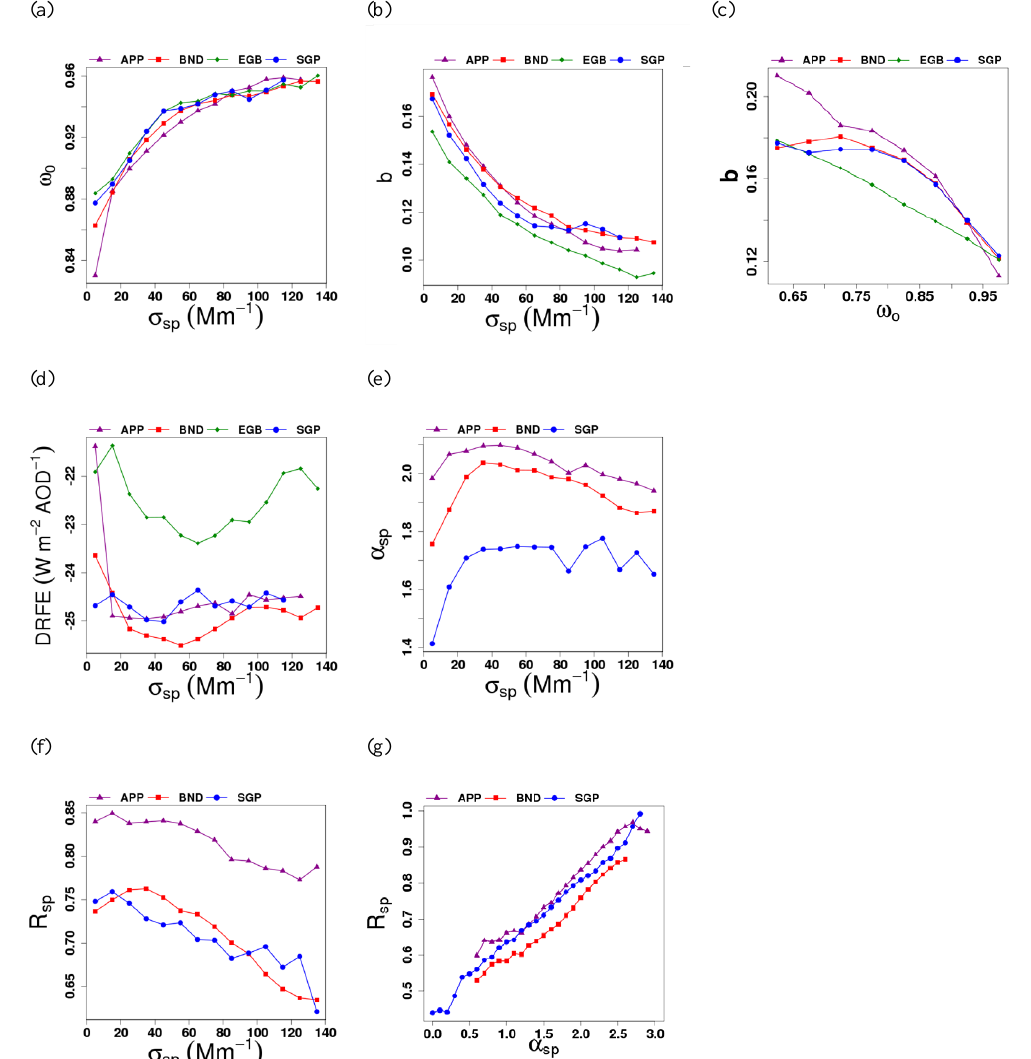
Figure 10. Systematic relationships among mean AOPs over full annual cycles of the 2010–2013 period at APP, BND, EGB, and SGP: (a) PM 1 ω 0 vs. PM 1 σ sp ; (b) PM 1 b vs. PM 1 σ sp ; (c) PM 1 b vs. PM 1 ω 0 ; (d) PM 1 DRFE vs. PM 1 σ sp ; (e) PM 10 α sp vs. PM 1 σ sp ; (f) R sp vs. PM 1 σ sp ; and (g) R sp vs. PM 10 α sp